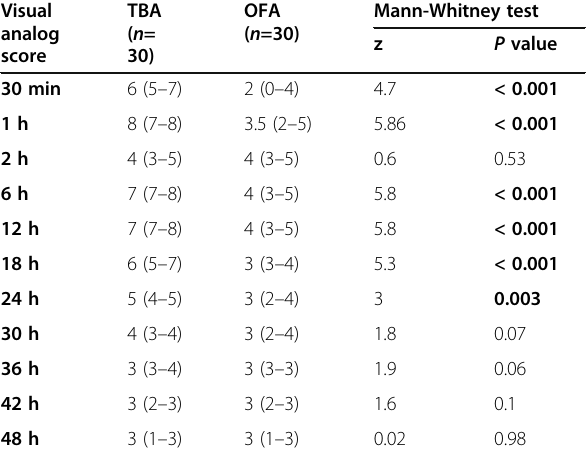
Table 6 Comparison between groups as regards postoperative nalbuphine consumption